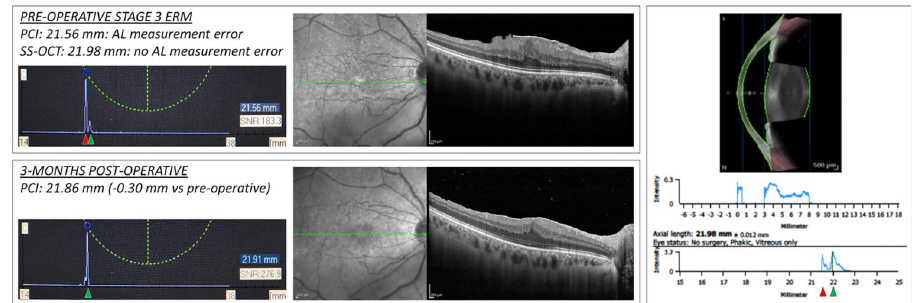
Fig 2. AL measurement error of the PCI device in a case of ERM stage 3. Left part, upper box: PCI biometric output in a case of ERM stage 3, as shown in the OCT B-scan on the right. The measured mean AL is 21.56 mm, as reported in the caption and in the blue rectangle. Left part, lower box: PCI biometric output of the same eye 3 months after combined cataract and vitreoretinal surgery with ERM removal. The measured mean AL is 21.91 mm. Right part: anterior segment SS-OCT device output. The measured mean AL is 21.98 mm. The pre-operative AL measurement obtained with the PCI was considered erroneous. In the pre-operative PCI biometric output, a double peak is present (first: red arrowhead; second: green arrowhead). After surgery, a single peak is present (green arrowhead), likely corresponding to the second smaller peak visible in the pre-operative output. The first peak in the pre-operative biometric output likely corresponds to the hyper-reflective vitreoretinal interface and the second to the RPE. In the SS-OCT biometric output, a moderate double peak is visible, with the first likely representing the vitreoretinal interface (red arrowhead) and the second the RPE (green arrowhead).